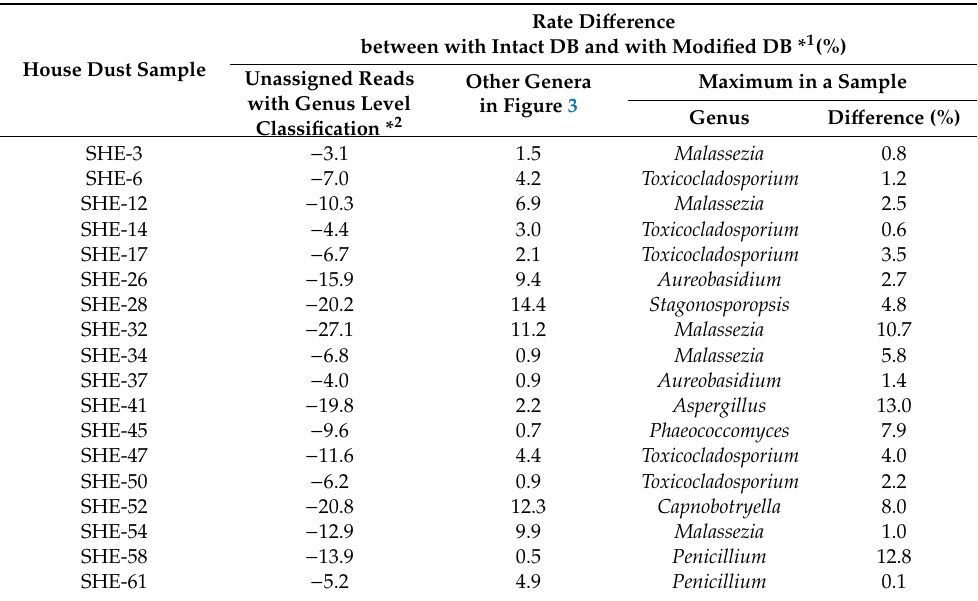
Table 1. Comparison of fungal occupancy rates between the use of the intact and modified database.